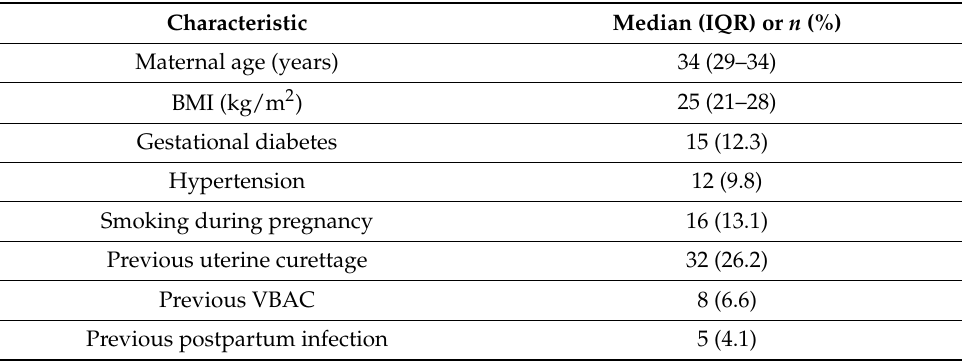
Table 1. Demographic and obstetric history of the study population ( n =